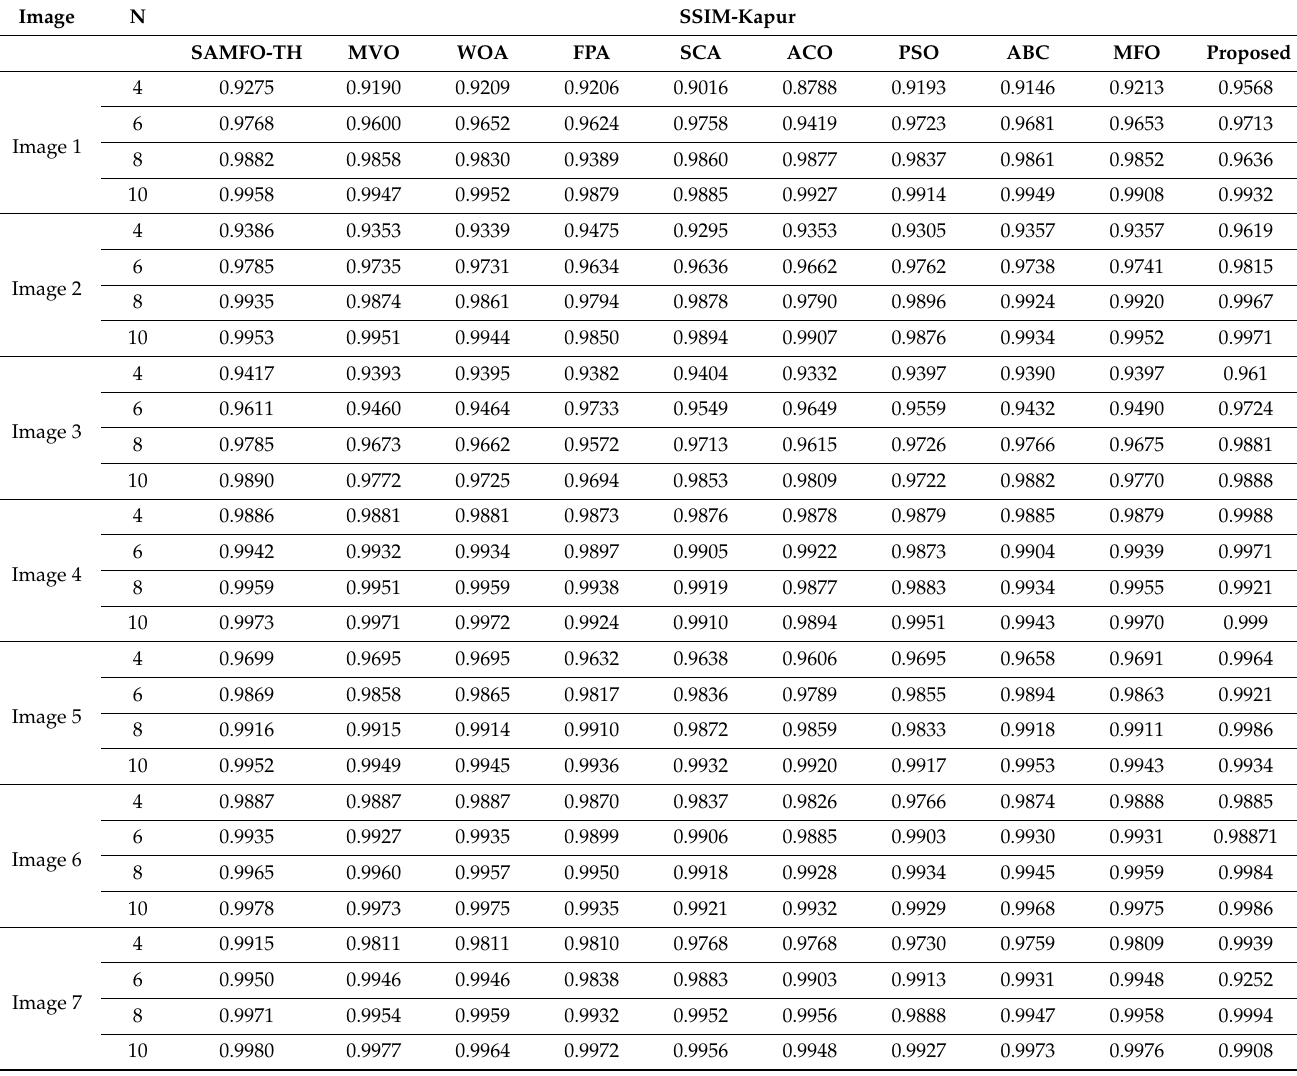
Table 4. Comparison of SSIM computed by SAMFO-TH, MVO, WOA, FPA, SCA, ACO, PSO, ABC, and MFO with the proposed model using Kapur’s method with N = 4, 6, 8, and